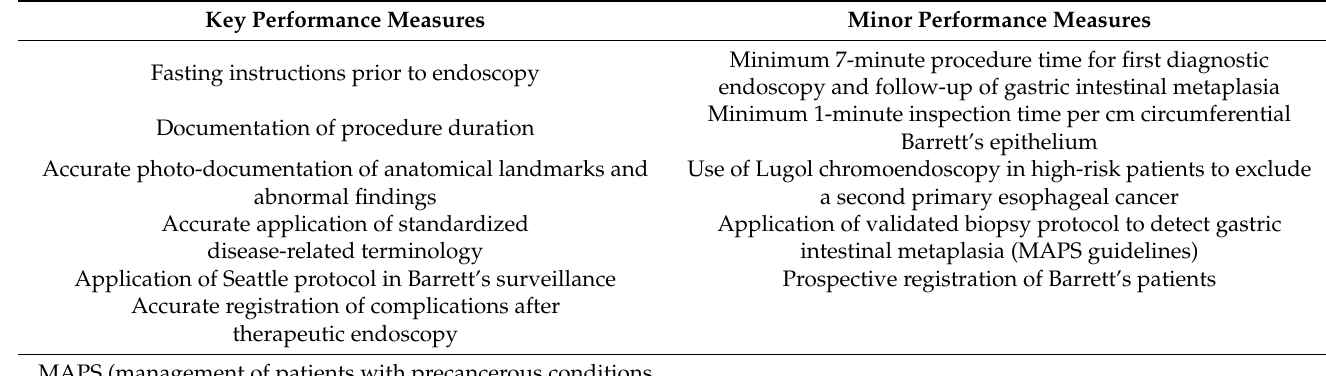
Table 2. Standard performance measures for upper gastrointestinal endoscopy. Adapted from Bisschops et al, Endoscopy 2016